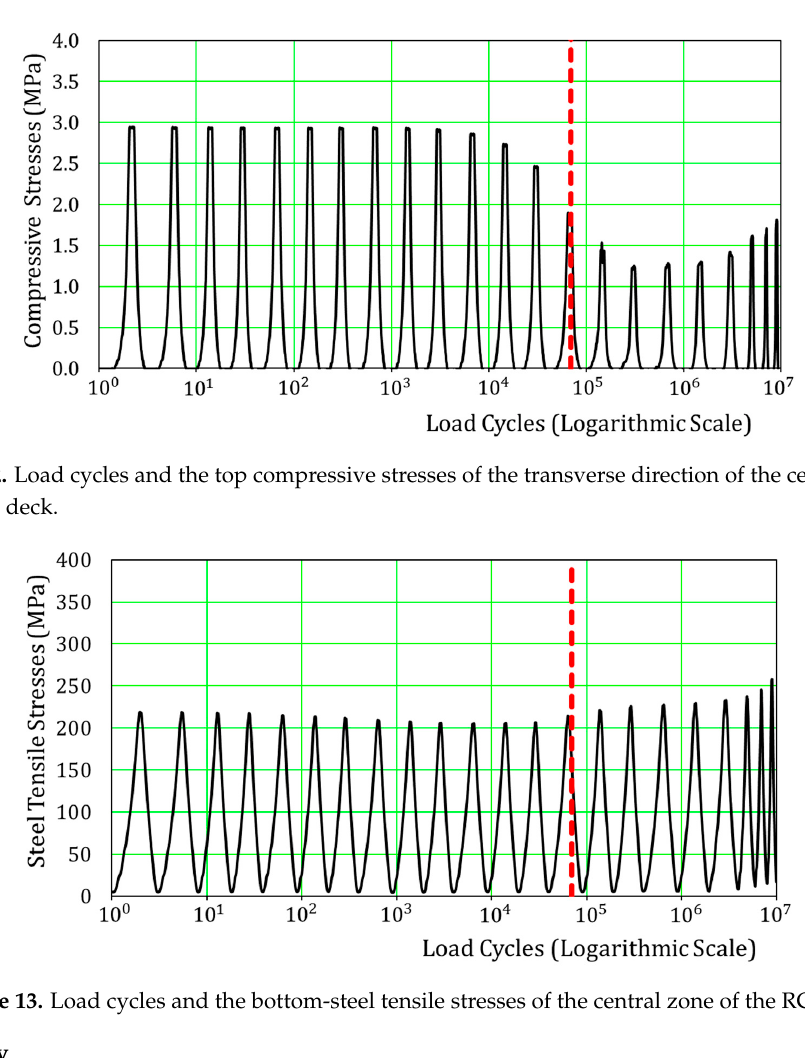
Figure 11. Load cycles and the pore water pressure of the central zone of the RC deck.